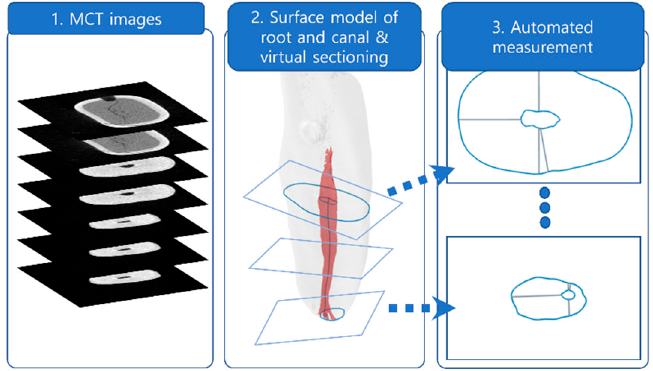
Figure 2. Overall process of the automatic measurement of root and canal dimensions. From the MCT images of mandibular incisors, 3D surface models of root canals were constructed and the central axis was plotted using V works 4.0; Cybermed, Seoul, Korea. Subsequently, surface models were sectioned perpendicular to the canal axis (at 0.1 mm intervals). Pre-defined anatomic parameters were computed in each section.